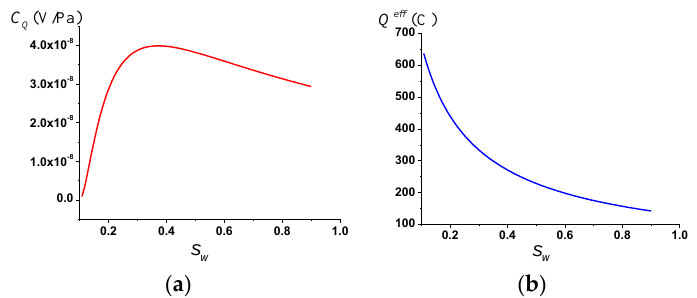
Figure 1. Effect of water saturation (steady case): ( a ) streaming potential coupling coefficient; ( b ) effective net residual charge density.